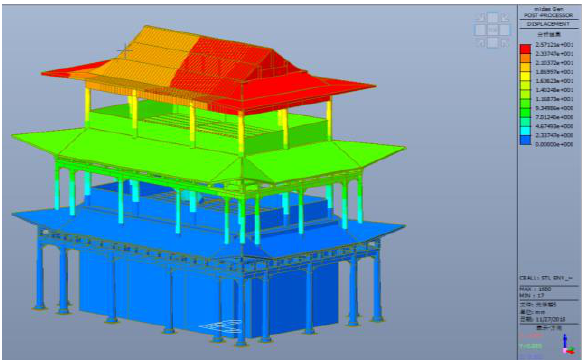
Figure 15. The maximum deformation graph of Guanghua Pavilion [ 光化楼